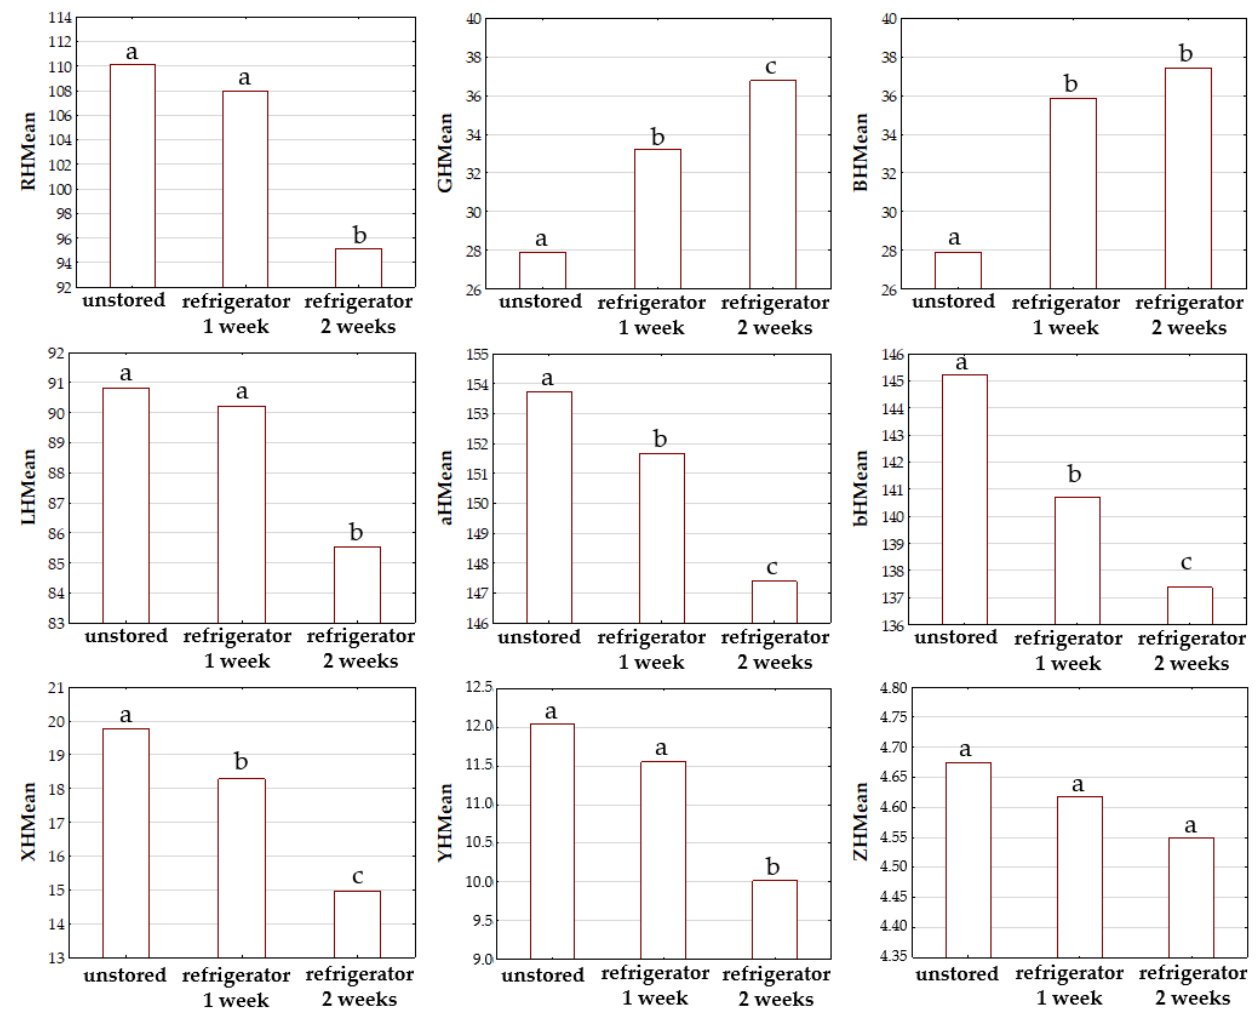
Figure 6. The differences in selected image texture parameters of red currants stored in the refrigerator caused by storage time. a,b,c — the same letters on one graph denote no statistical differences between samples.